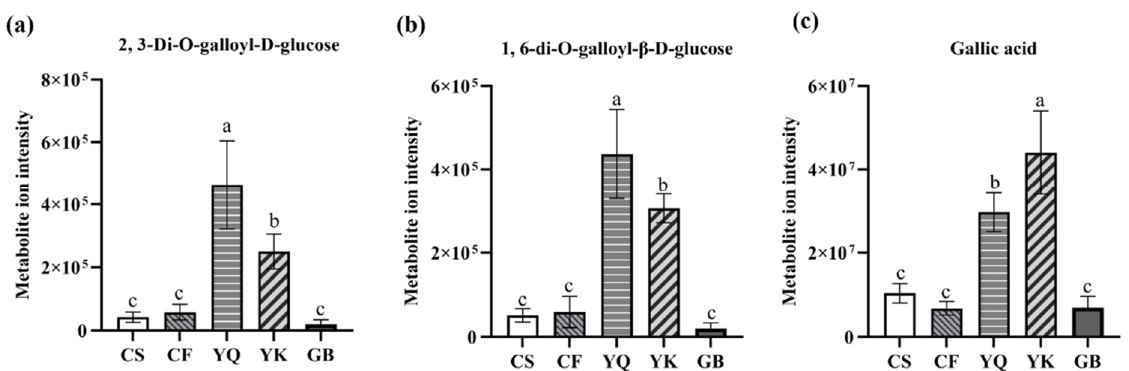
Figure 6. The total ion intensity of three classes of phenolic metabolites in FDRs from different producing areas. ( a ) 2, 3-di- O -galloyl- D -glucose, ( b ) 1,6-di- O -galloyl-β- D -glucose, ( c ) gallic acid. Bars represent the sum of ion intensity of all metabolites belonging to each class. The a, b, c above the bar chart indicates the difference significance; and the two comparison groups with no significant difference were marked with the same letter; The significance value was a > b > c.